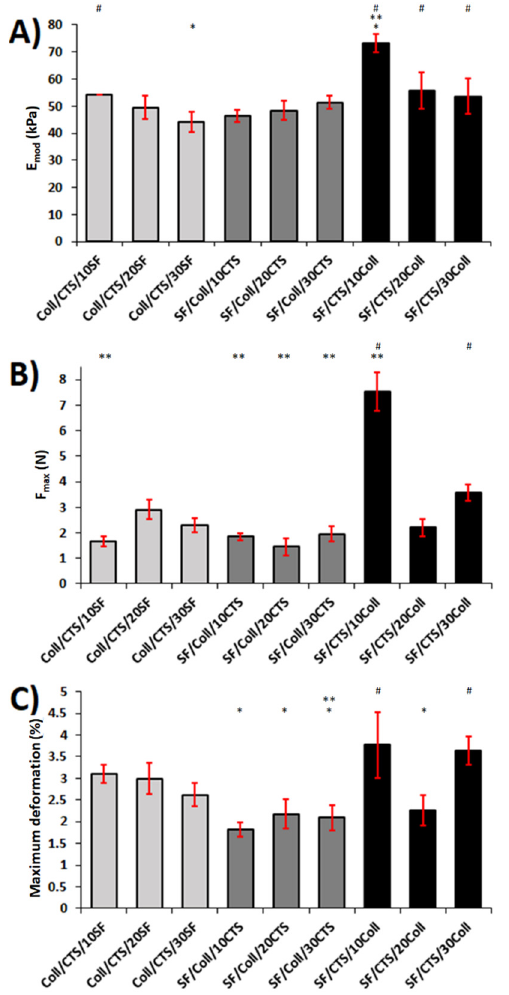
Figure 9. Results (( A ) Young’s modulus, ( B ) maximum force and ( C ) maximum deformation) of mechanical testing of samples immersed in wet conditions (PBS solution) for each kind of scaffold ( n = 5, mean ± SD, * significantly different vs. Coll/CTS/10SF, ** significantly different vs. Coll/CTS/20SF, # significantly different vs. Coll/CTS/30SF, p < 0.05).